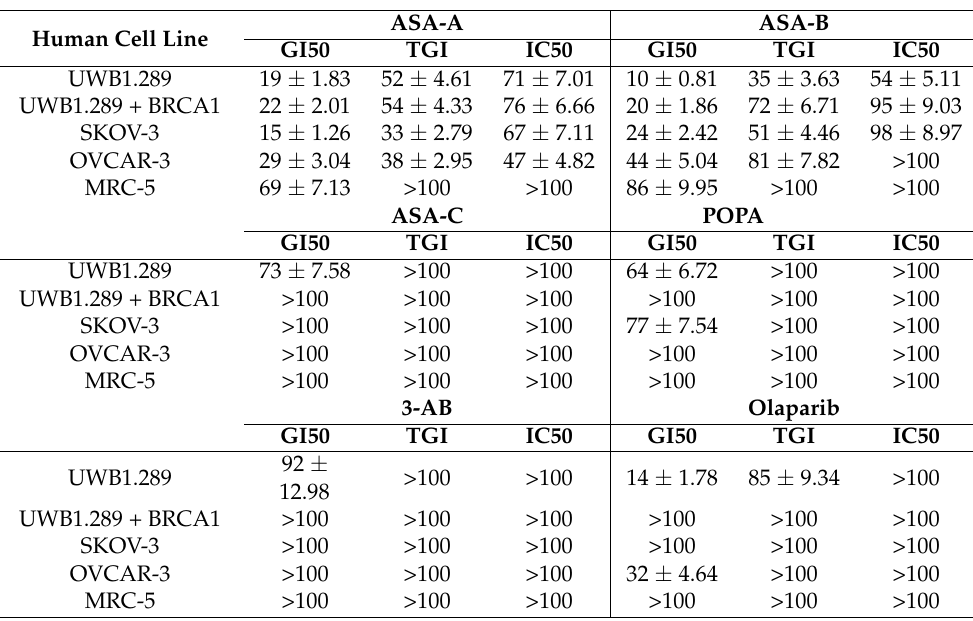
Table 2. In vitro cytostatic (IG50 and TGI ± SEM) ( µ M) and cytotoxic (IC50 ± SEM) ( µ M) effects of compounds ASA-A, ASA-B, ASA-C, POPA, 3-AB and Olaparib on all four studied human ovar- ian cancer cell lines in vitro. All values are representative of experiments performed in triplicate (Significance level, p <